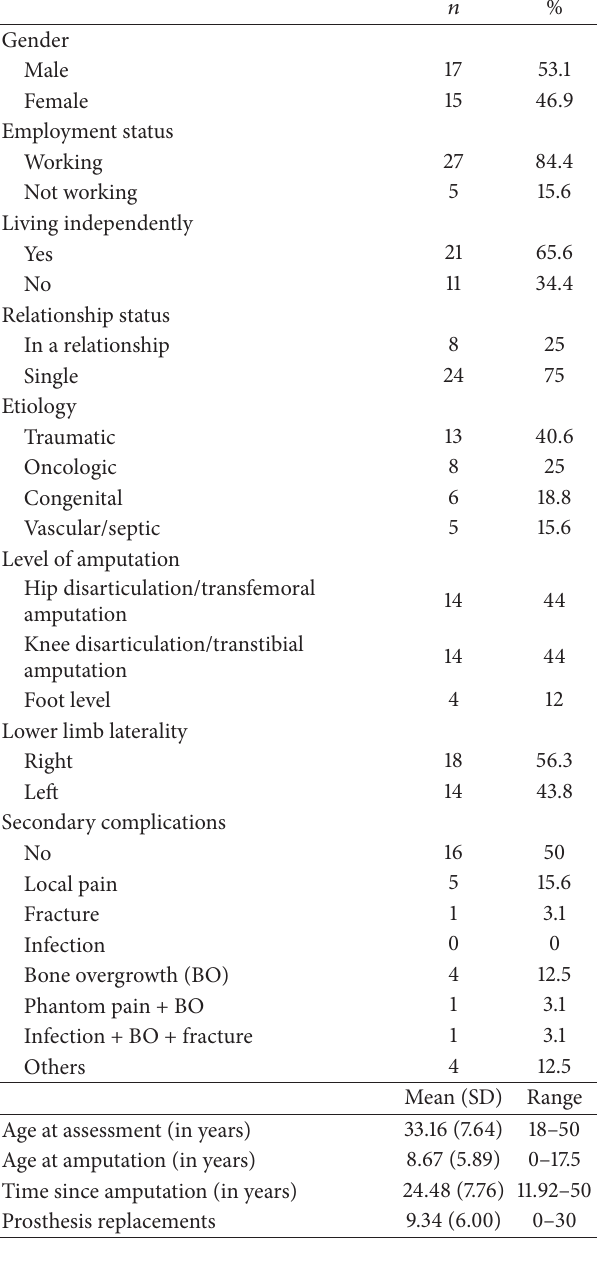
Table 1: Demographics and medical characteristics of the sample ( 𝑁 = 32